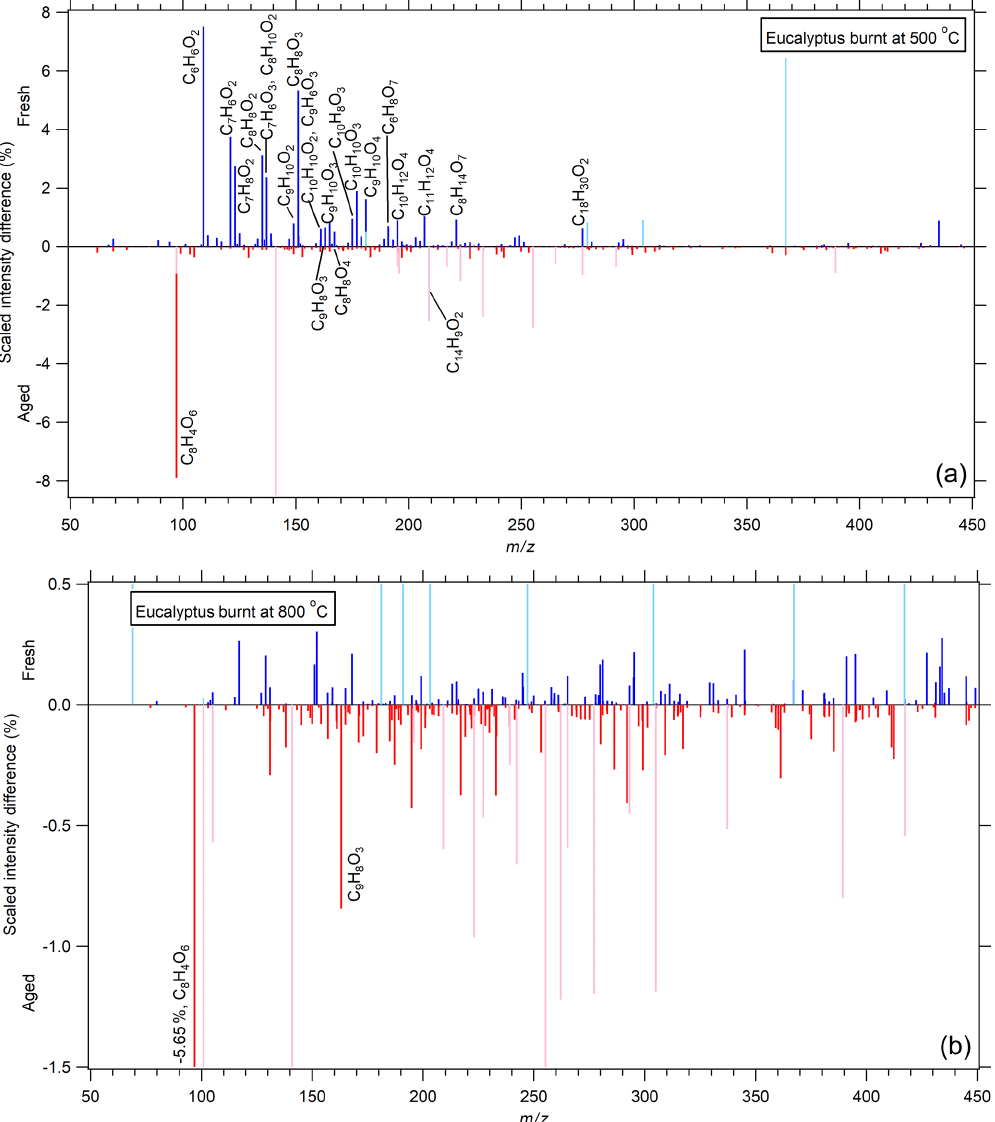
Figure 2. A comparison of eucalyptus-derived BB aerosol combusted at 500 ◦ C (a) and 800 ◦ C (b) under fresh and photochemically aged conditions with VOCs in terms of the scaled intensity difference (see Sect. 2.5). Species more present in the fresh sample have positive values (blue lines), while those more present in the aged sample have negative values (red lines) (i.e., species with positive values have been removed because of the aging process, while those with negative values are either produced or represent a greater relative contribution to the aged sample). Peaks in lighter colors were present in the XCMS analysis but were found to be present in significant amounts in the blank sample. Many of these peaks that were found in the blank extend past the scale of the plot but were cut off to focus on species associated with BB aerosol. Compounds having an absolute difference greater than 0.5% have been labeled. There is very little change for combustion at 800 ◦ C, while 500 ◦ C shows a net removal of many